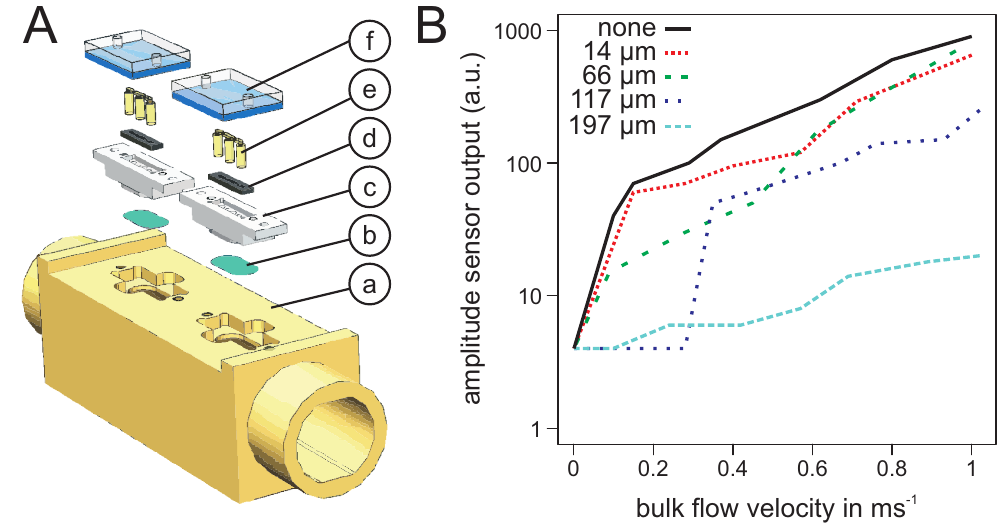
Figure 11. Verification of an artificial CN sealed with a PDMS membrane by flow-induced